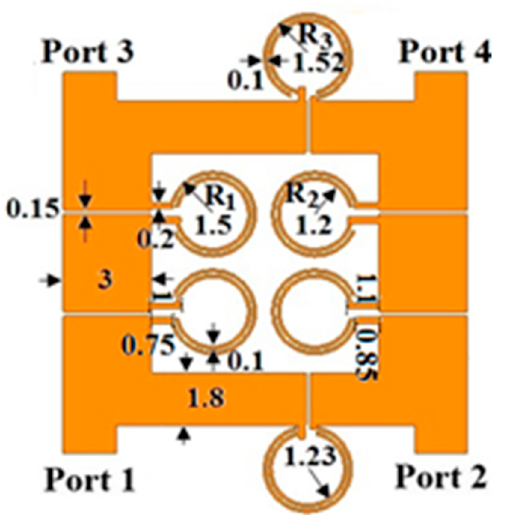
Figure 1. Topology of designed dual band/dual mode coupler (all dimensions are in mm).